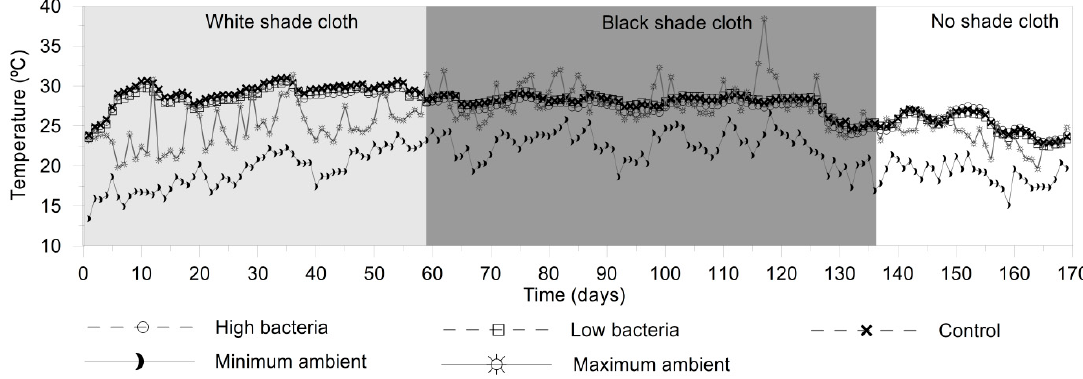
Figure 1. Evolution of water temperature, minimum and maximum ambient temperature values are shown along the study period. Each data represents the average of the three experimental units for high bacteria treatment (2.8 × 10 4 cfu/mL), low bacteria treatment (2.8 × 10 3 cfu/mL) and control treatment.